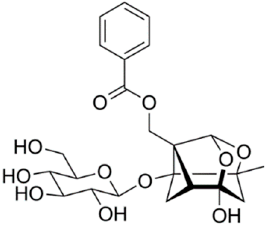
Figure 6. Chemical structure of paeoniflorin.